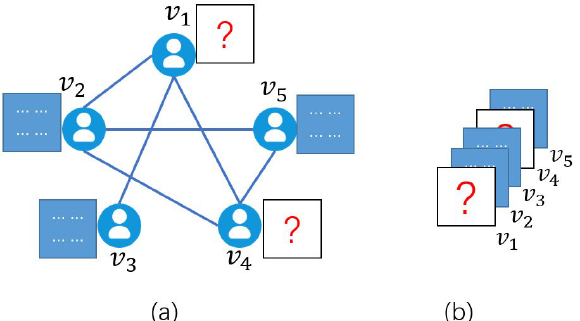
Figure 1. ( a ) A social network represented as a graph. ( b ) A graph-tensor corresponds to the graph of ( a